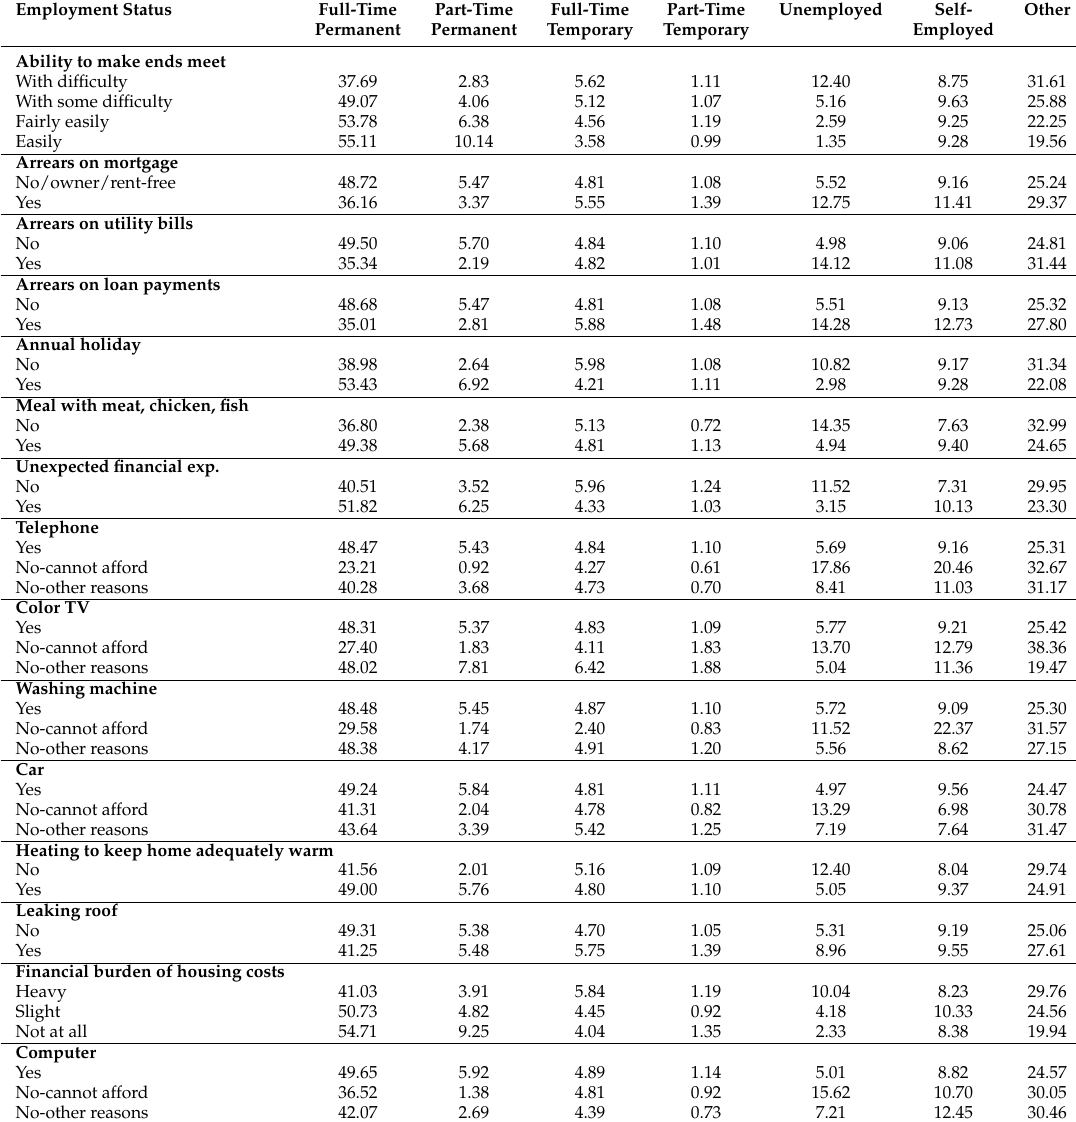
Table 3. Conditional percentage distribution of employment status (%) given economic deprivation